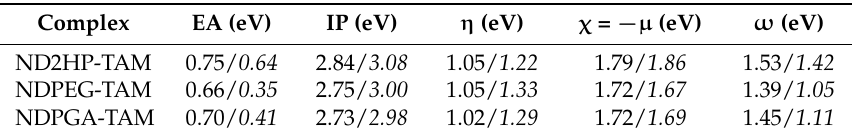
Table 4. Reactivity parameters of complexes calculated with energies approximation/ HOMO- LUMO approximation